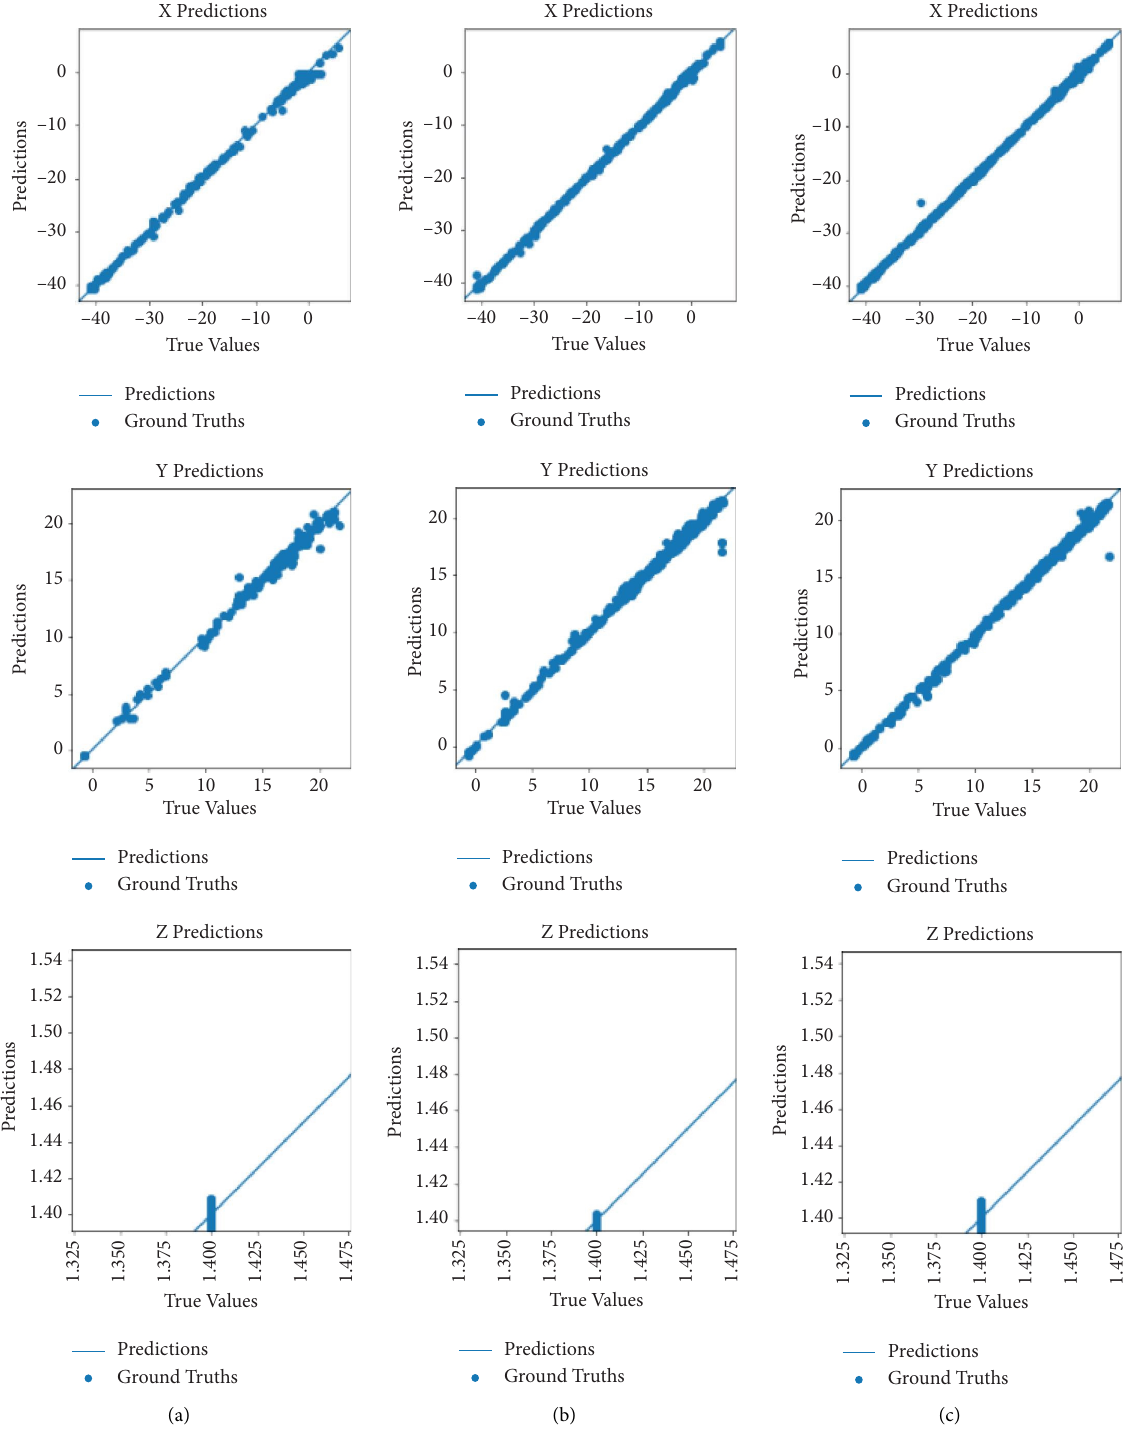
Figure 7: FCDNN predictions (a) 1 AP pair, (b) 2–10 AP pairs, and (c) 1–10 AP